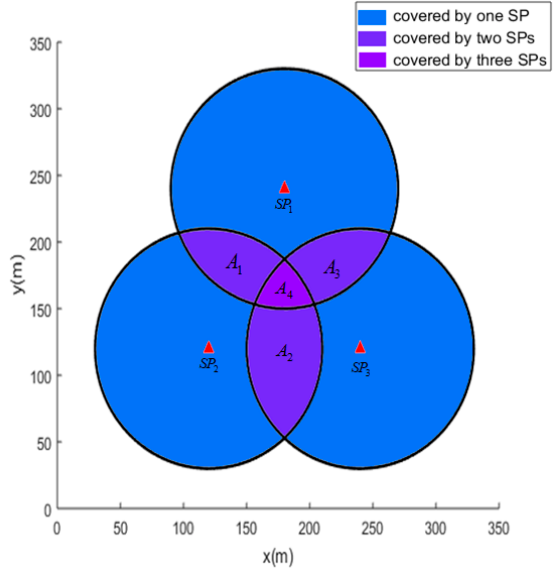
Figure 5. Covered areas of the mobile collector.